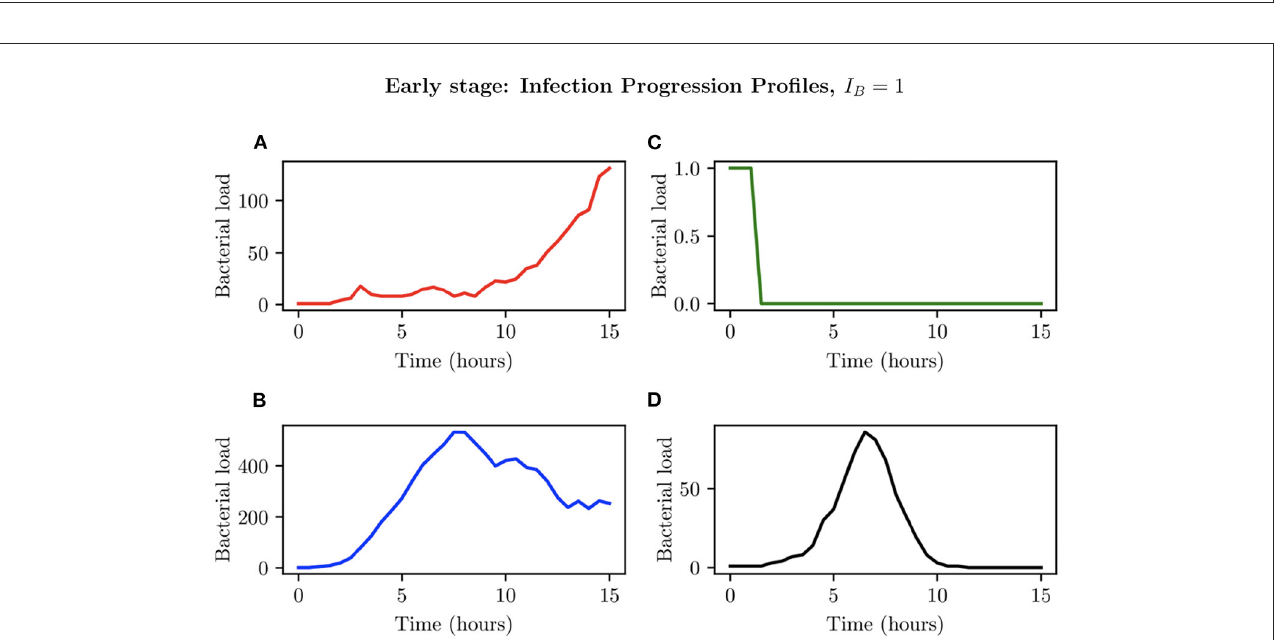
FIGURE5 Simulations (A–D) represent 4 different bacterial growth profiles arising with I B =